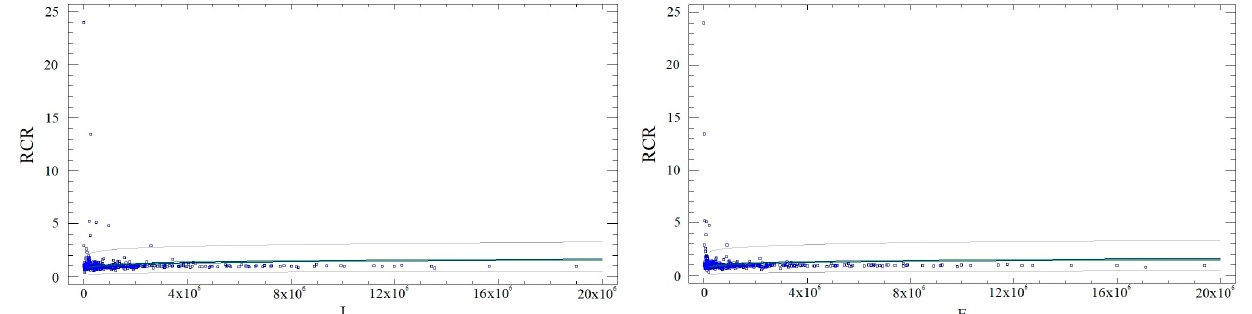
Figure 6. Illustration of the dependence of the RCR index on income and expenditure in 2004 (non-cooperatives). Table 5. Regression functions of the relationship of the RCR index with income/expenditure in the years 2004–2019 (non-cooperatives).